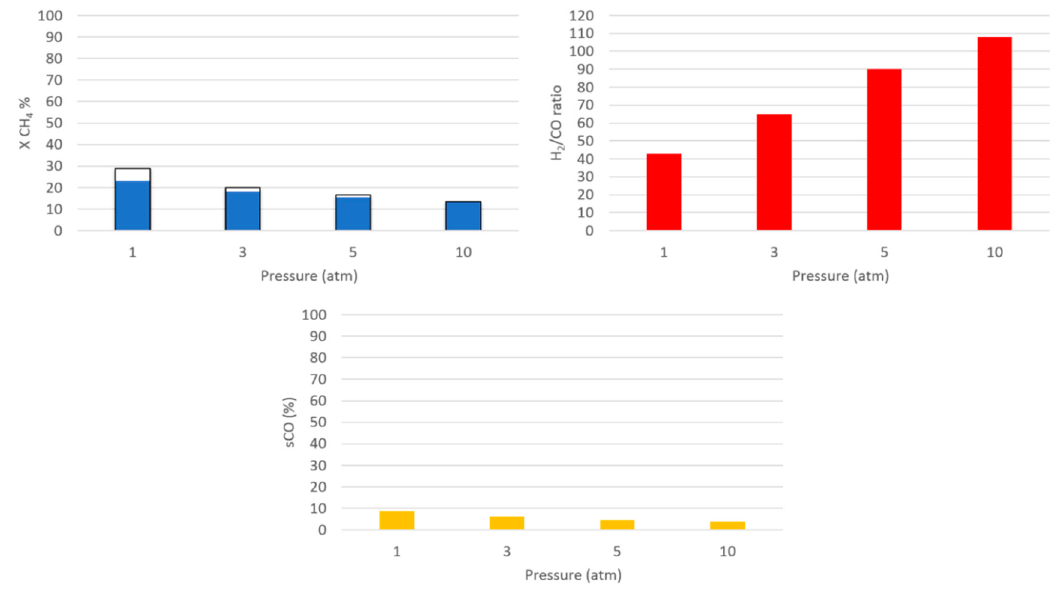
Figure 8. Comparison among tests carried out on Rh0.6-CL-R-CZOm at 30,000 h − 1 , S / C 2 and 500 ◦ C. The graphs report the methane conversion (blue) with respect to the equilibrium values (white bars with black frames), H 2 / CO ratio (red) and CO selectivity (yellow) versus di ff erent GHSV. The Y scale related to the H 2 / CO-ratio graph is slightly di ff erent from the others due to higher